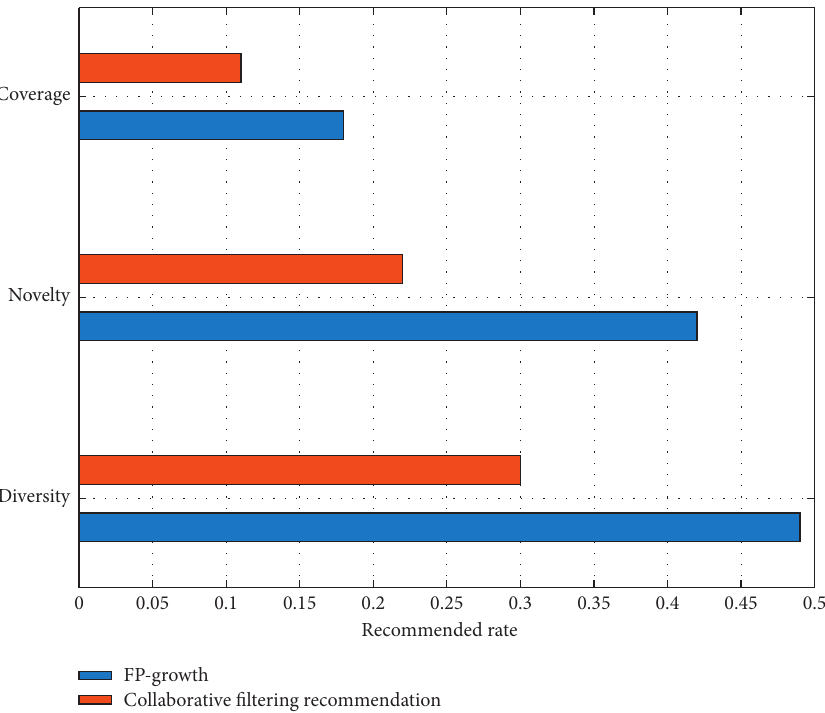
Figure 3: Comparison and analysis table of recommendation